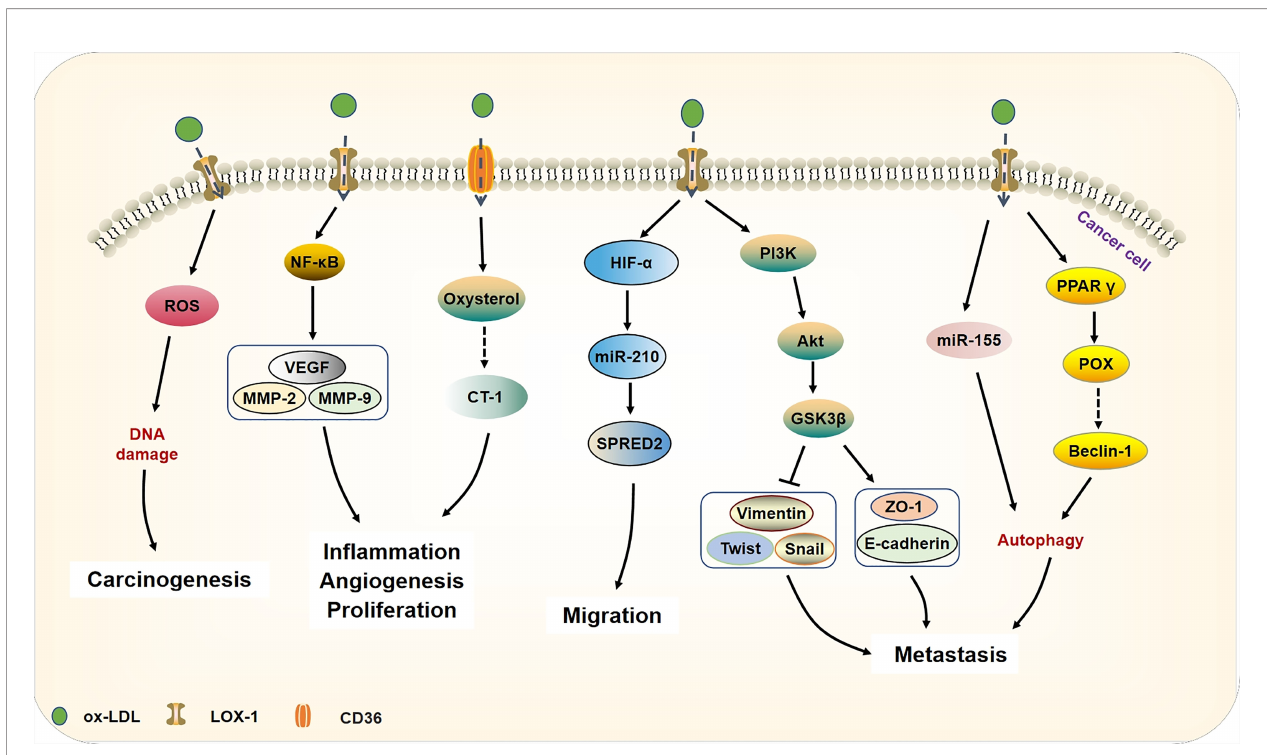
FIGURE 3 | Ox-LDL binds to its receptor CD36 or LOX-1 and participates in tumorigenesis and development. Ox-LDL can cause DNA damage by generating ROS, thereby increasing the risk of carcinogenesis. Besides, ox-LDL binds to LOX-1 and activates NF- k B target genes (VEGF, MMP-2, MMP-9) to increase cell proliferation, motility, and angiogenesis. In addition, ox-LDL is also internalized by CD36 and further accumulates oxysterol metabolites, leading to the cytokine CT-1 expression that can promote in fl ammation and angiogenesis in cancer. Ox-LDL increases the expression of miR-210 by activating the expression of HIF- a and then down-regulating SPRED2, which leads to cancer cell migration. Furthermore, through triggering the PI3K/Akt/GSK3 b cascade, ox-LDL can promote EMT in cancer. Autophagy is an important mechanism of ox-LDL involved in cancer EMT, ox-LDL induces cancer cell protective autophagy by activating miR-155 and regulating prolinase POX. Through the activation of POX, ox-LDL produces superoxide and up-regulates beclin-1, thereby mediating cancer cell